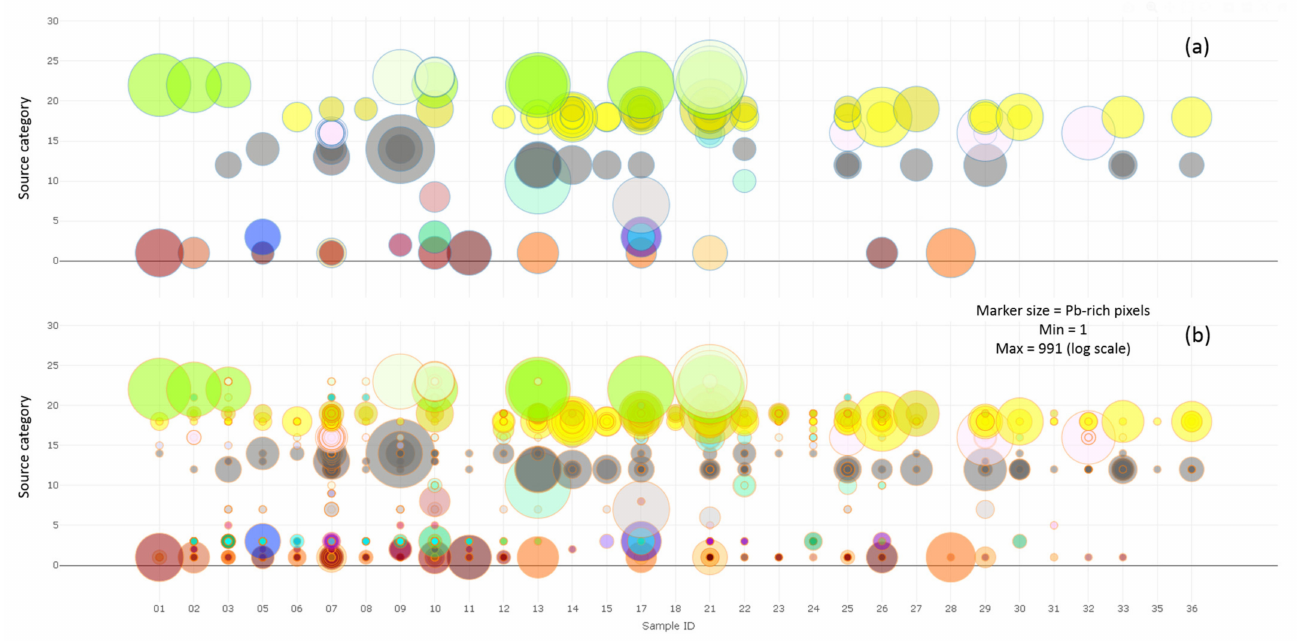
Figure 13. All individual occurrences of Pb-rich phase per grain, represented by markers plotted by sample and interpretive source category, with marker size representing absolute area of Pb-rich phase (pixels) per grain (logarithmic scale). Colour- scheme as Figure 8, indicating grain population. ( a ) shows all occurrences of ≥ 5 pixels, ( b ) shows all occurrences. Tabulated data provided in Supplementary File